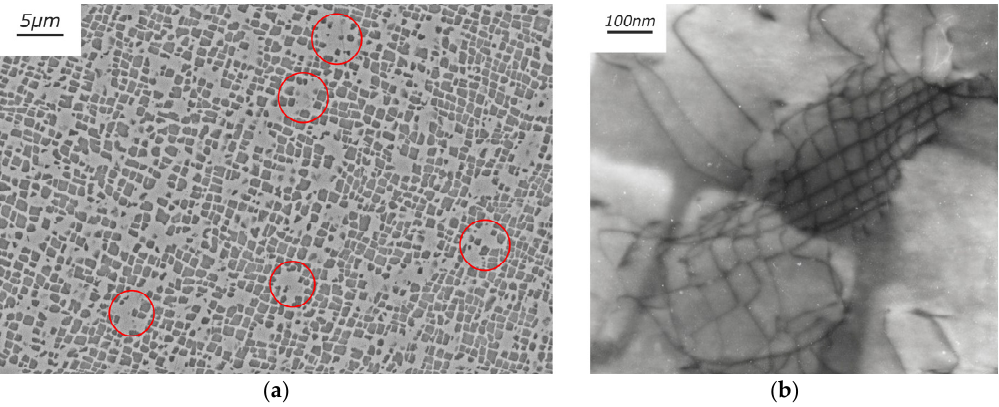
Figure 3. Microstructure of the PWA 1483 superalloy; some PFZ are evidenced by red circles ( a ); TEM micrograph displaying a network of dislocations in a PFZ ( b ).